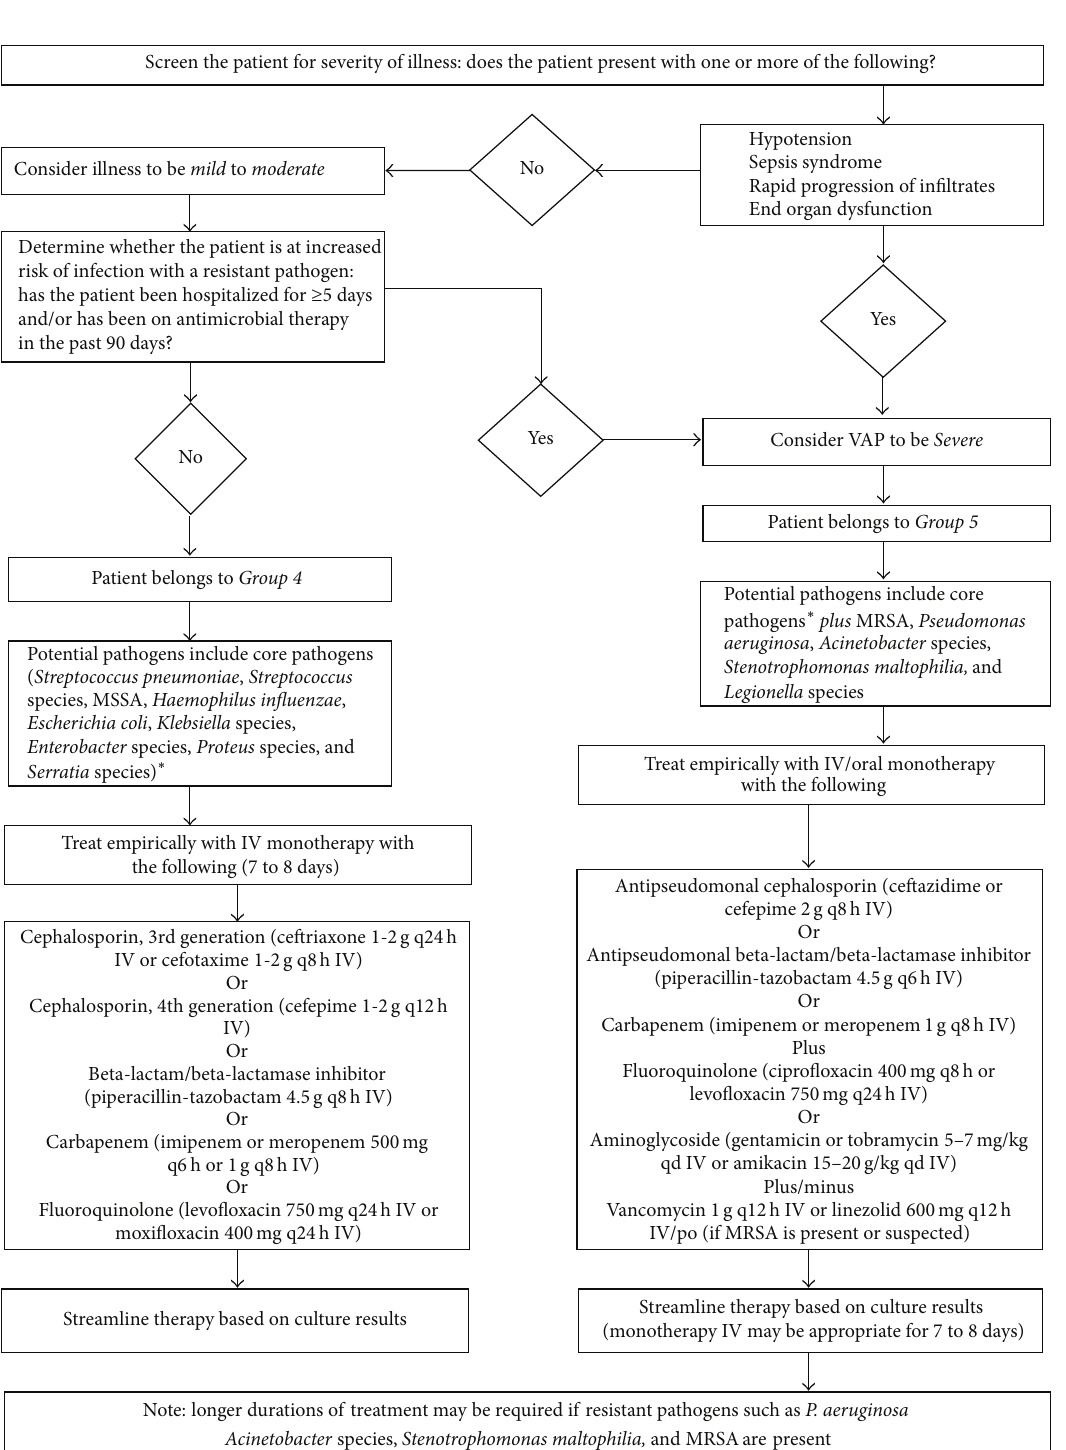
Figure 7: ∗ Core pathogens include Streptococcus pneumoniae , Streptococcus species, Haemophilus influenzae , Enterobacter species, Escherichia coli , Klebsiella species, Proteus species, Serratia marcescens , and methicillin-susceptible Staphylococcus aureus .